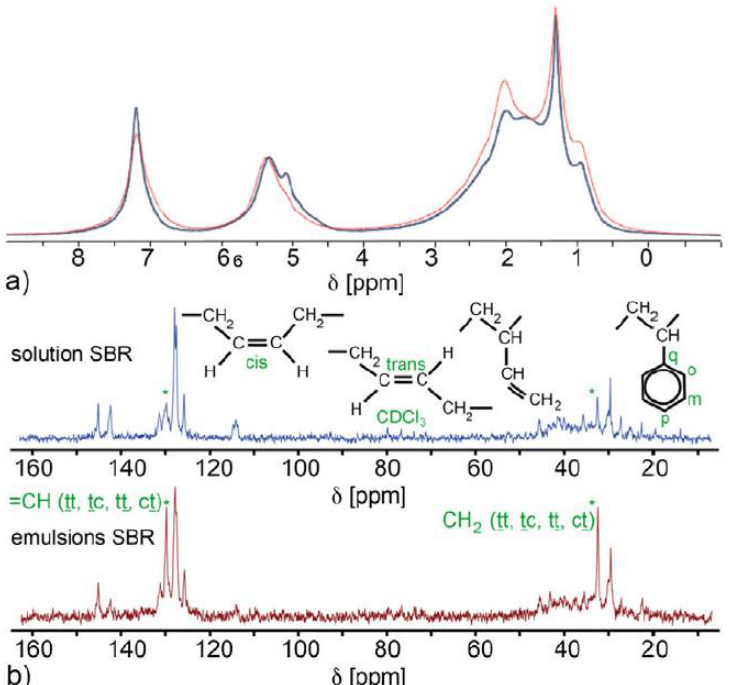
Figure 3. 1 H and 13 C NMR spectra of solution polymerization- and emulsion polymerization-prepared SBR recorded on a 1 T (43 MHz) benchtop NMR spectrometer. A 50 mg sample of each polymer was dissolved in 0.5 mL CDCl 3 . The polymerization process had an effect on both 1 H and 13 C spectra. Adapted with permission from [51], Wiley, 2016.